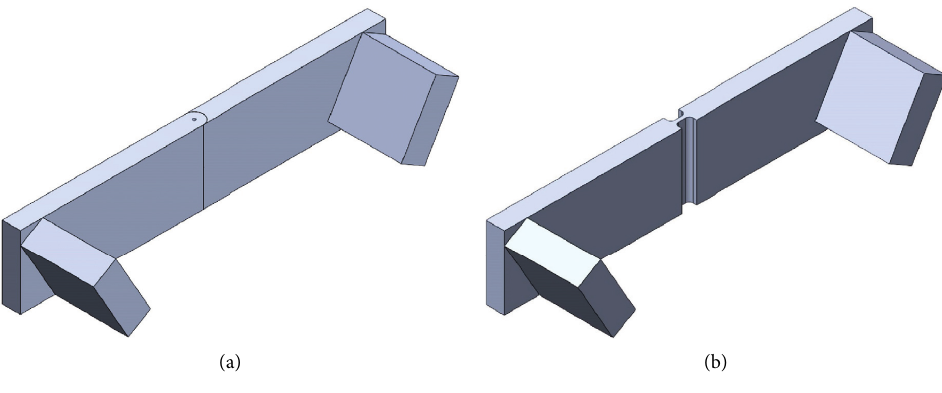
Figure 8: Original hinge (a) and compliant hinge